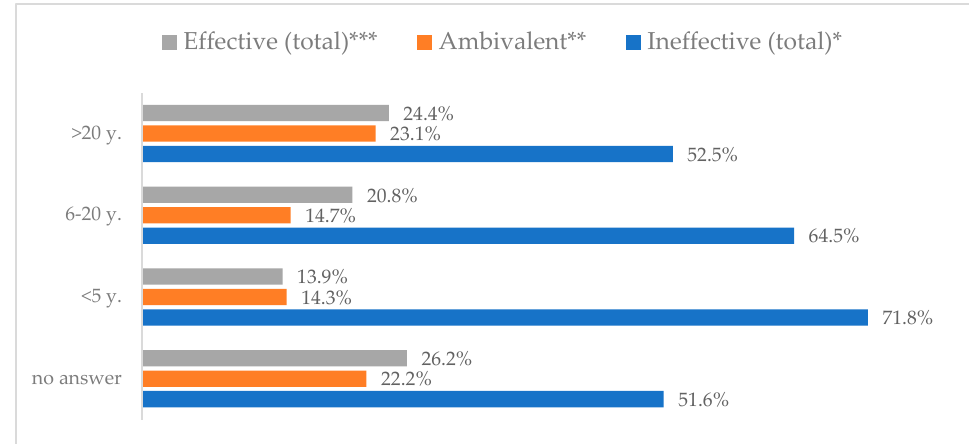
Figure 34. Taking vitamin C daily to prevent influenza virus infection by profession ( N = 905). *Sum of responses: completely ineffective, ineffective, rather ineffective; **Response: neither ineffective nor effective; ***Sum of responses: rather effective, effective, completely effective.